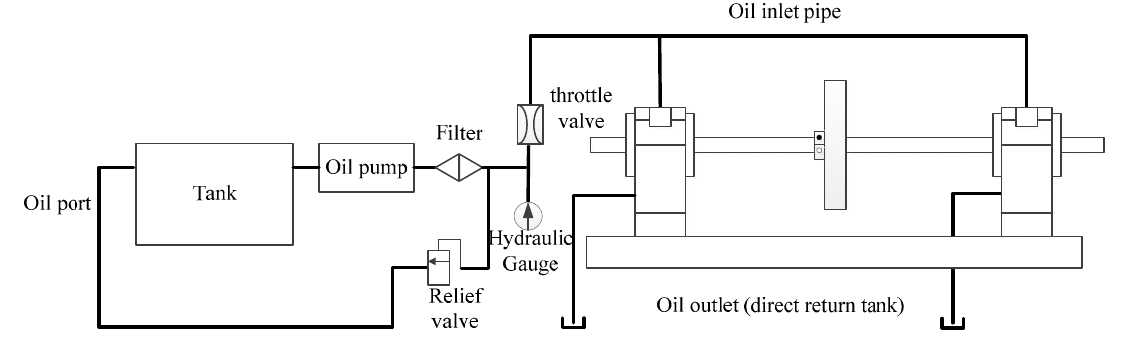
Figure 4. Oil supply device.